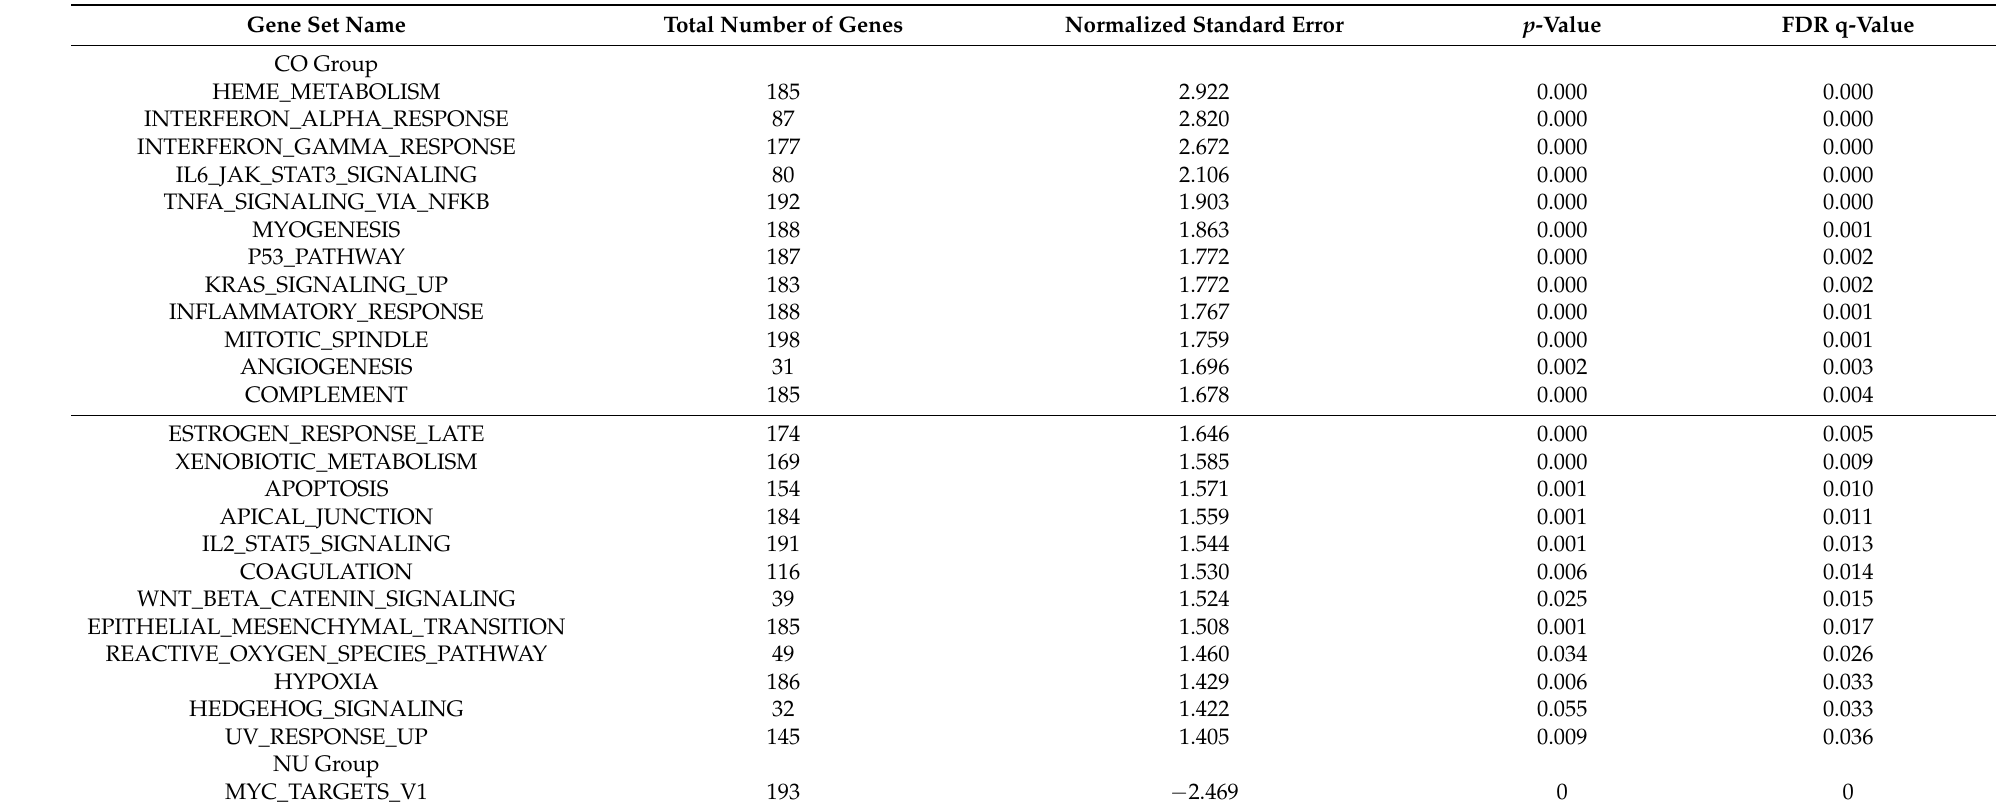
Table 4. Significantly enriched gene groups in PB, respectively for CO and NU groups, according to the Hallmark collection, at weaning